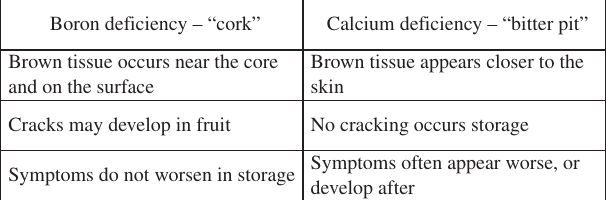
Source: Adapted and modified from Dart